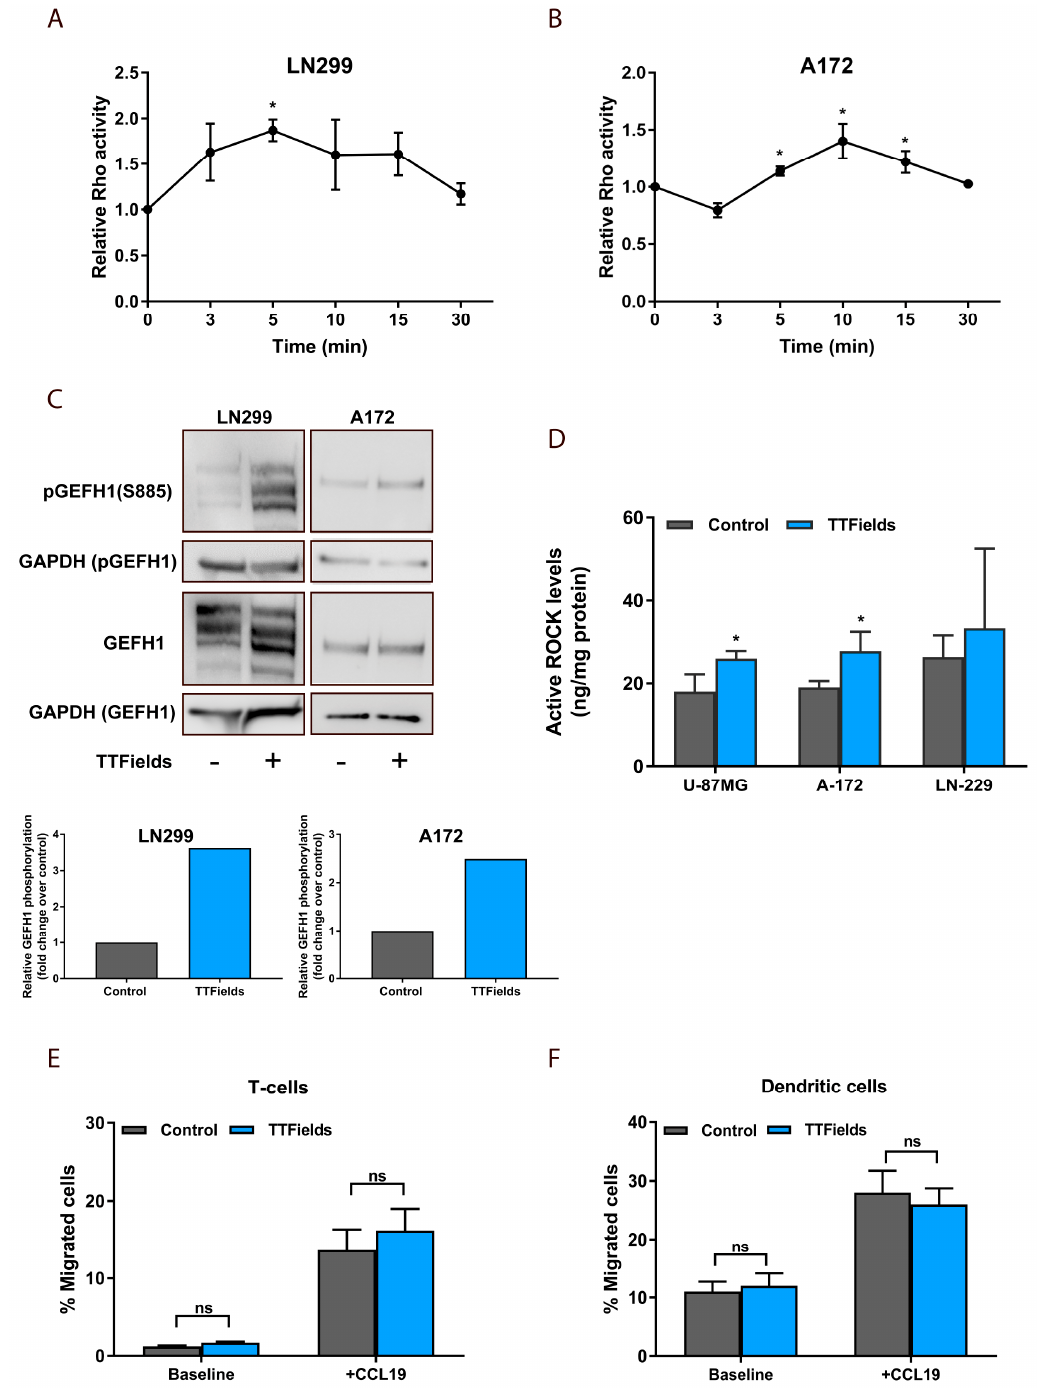
Figure 5. TTFields activate GEF-H1 and inhibit cancer cell motility in a Rho-dependent manner ( A , B ) A-172 and LN-229 glioblastoma cells were treated with TTFields for the indicated times and RhoA activation was assessed. Mean + SEM; paired t -test. ( C ) Western blot analysis of GEF-H1 phosphorylated on Ser886 and the total GEF-H1 levels in control and TTFields-treated cells (top panel). Quantification of normalized relative levels of P-GEF-H1 compared to total GEF-H1 levels from two western blots for each condition (bottom panel). ( D ) ROCK activity in A-172, LN-229, and U-87 MG cells treated with TTFields for 24 h. ( E , F ) Migration responses of ( E ) T-cells and ( F ) dendritic cells using the modified Boyden chamber either with or without CCL19. ns, not significant. Mean + SEM; paired t -test. * p <